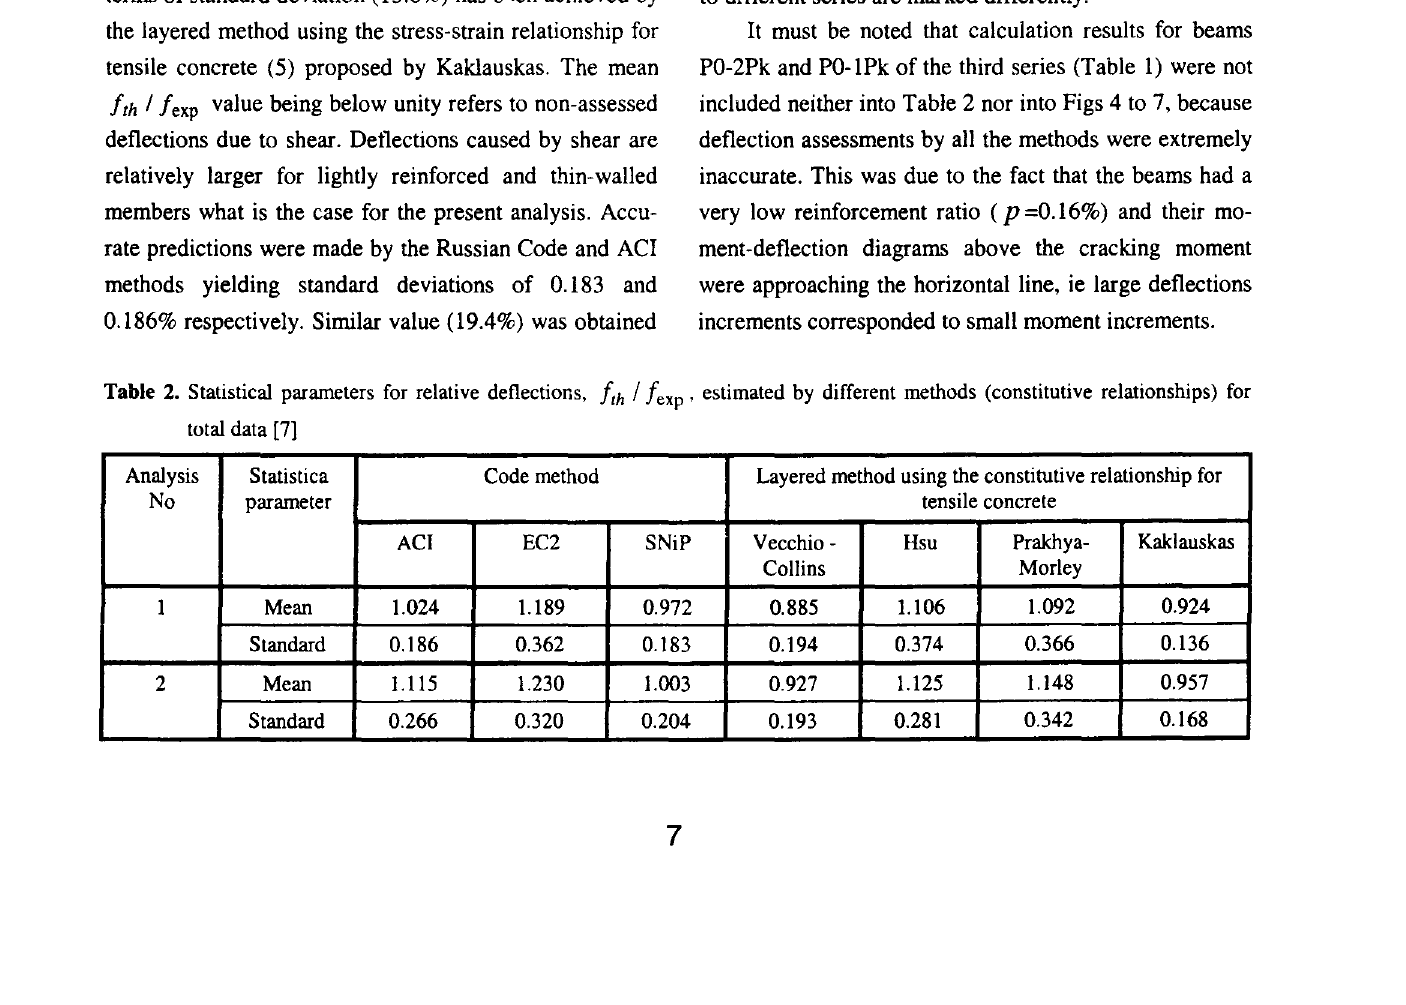
Table 2. Statistical parameters for relative deflections, fth I fexp , estimated by different methods (constitutive relationships) for total data